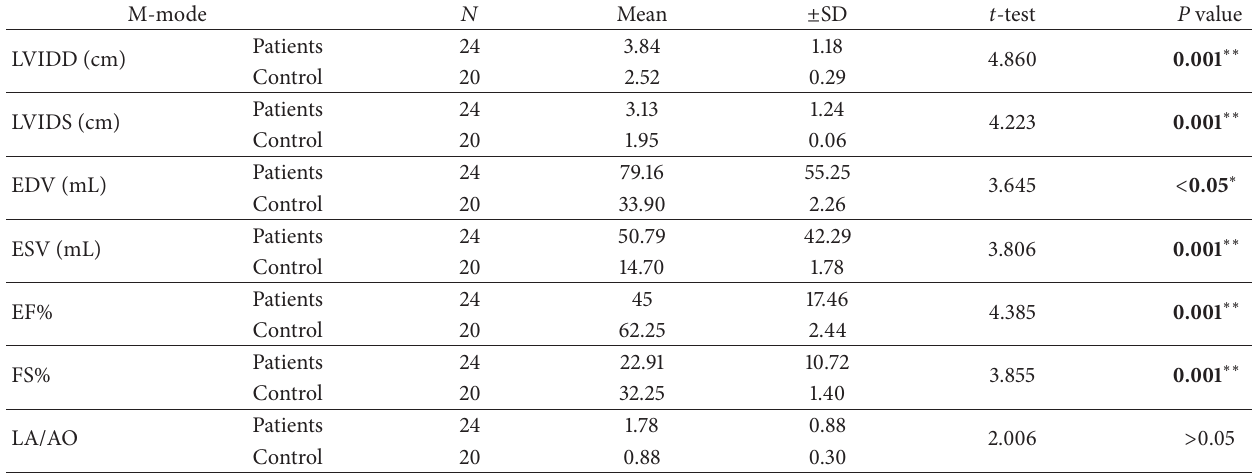
Table 3: M-mode echocardiographic data of patients compared to controls.